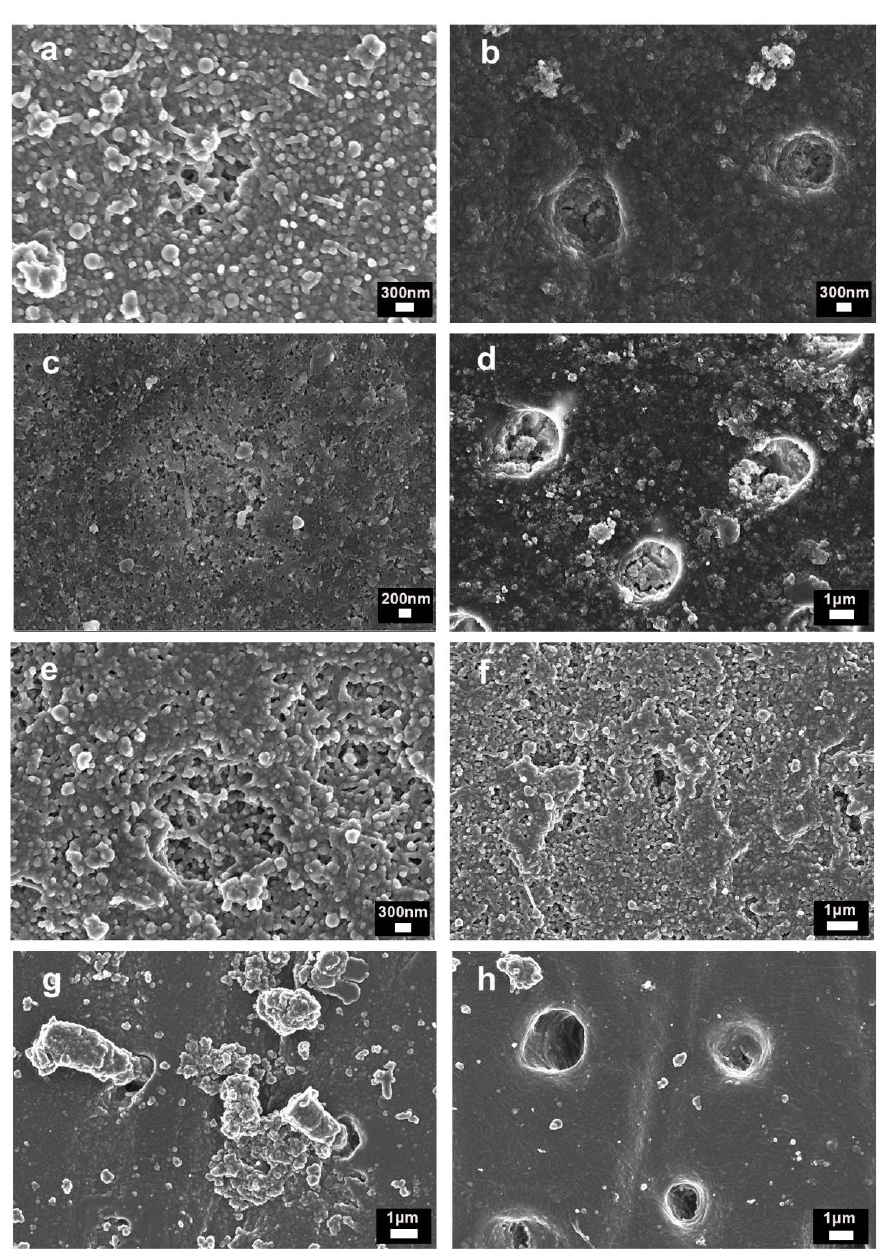
Figure 4. FESEM images of the dentin surfaces after EDTA-treatment and: ( a ) brushed with toothpaste containing 1% of Zn-NPs, where a single tubule occluded by NPs and new mineral formations were visible; ( b ) brushed with toothpaste containing 1% of Zn-NPs, for which occluded tubules were observed after acid application. Intertubular dentin was also covered by NPs and new minerals; ( c ) brushed with toothpaste containing 5% of Zn-NPs. A dentinal tubule occluded by NPs and new mineral formations were detected; ( d ) brushed with toothpaste containing 5% of Zn-NPs and after-treated with citric acid. Occluded and partially filled tubules are shown. Intertubular dentin was remineralized; ( e ) brushed with toothpaste containing 10% of Zn-NPs. Filled tubules and intertubular dentin covered by NPs and new minerals; ( f ) brushed with toothpaste containing 10% of Zn-NPs and after-treated with citric acid. A tiny tubule (about 250 nm) orifice was detectable on the dentin surface; ( g ) brushed with Sensodyne ® toothpaste, where tubules were occluded by smear plugs, which were dislodged from the main dentinal orifice; ( h ) brushed with Sensodyne ® toothpaste and after-treated with citric acid, for which intertubular dentin was demineralized and collagen fibers were